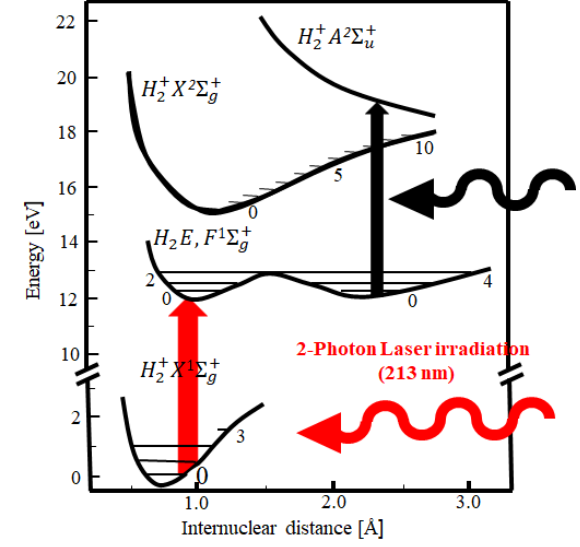
Fig. 17. Resonance Enhanced Multi-Photon Ionization (REMPI). A first Pump Laser 2-photon irradiates the ejected molecules and a second laser by ionizing them differentiates the ortho and para